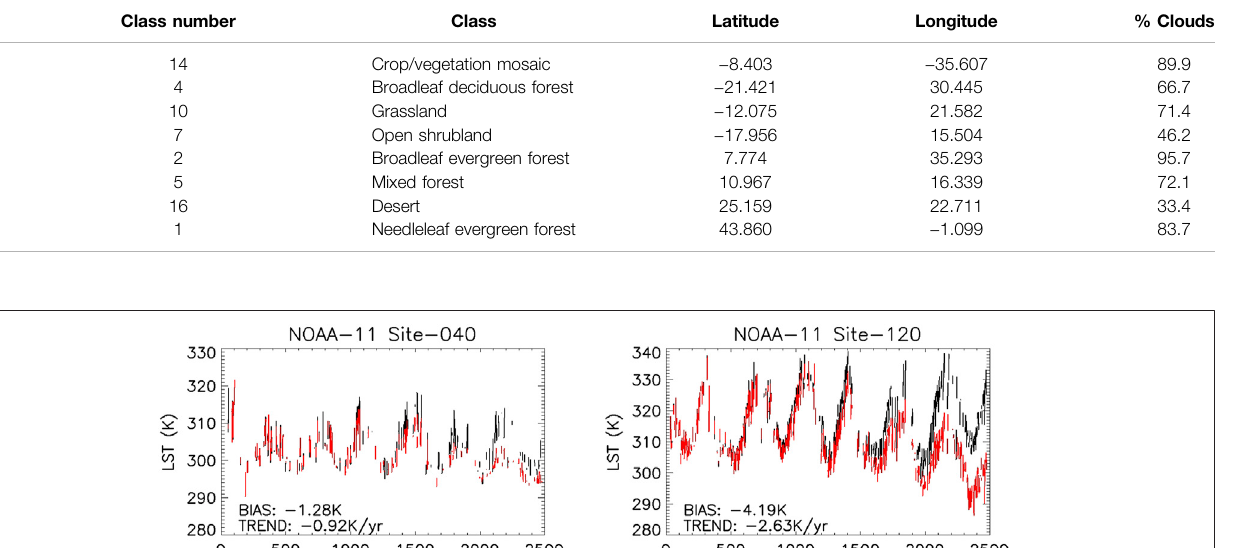
Frontiers in Remote Sensing |